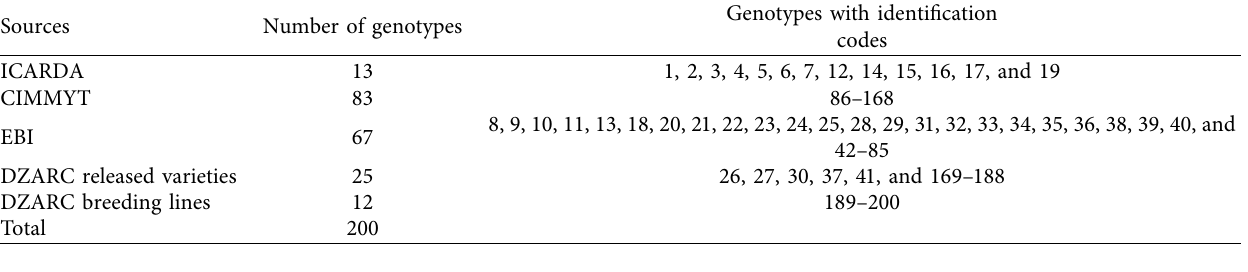
Table 3: Sources, numbers, and identifcation codes of durum wheat genotypes tested under an optimum and low-nitrogen environment at Debre Zeit, Chefe Donsa and Minjar areas during the 2020 main cropping